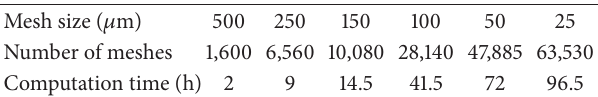
Table 5: Number of meshes and computational time for six kinds of mesh sizes using hexahedron